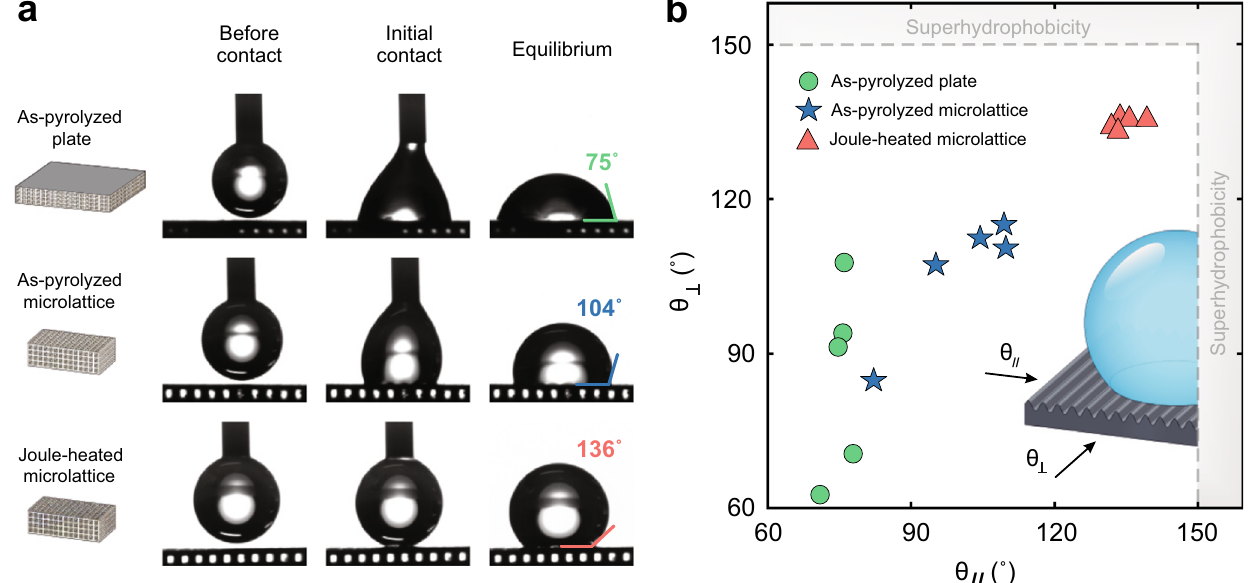
Fig. 4 Water contact angle measurements on pyrolytic and Joule-heated carbon. a Representative con fi gurations of a 0.7 µ l water droplet on an as- pyrolyzed plate, as-pyrolyzed microlattice, and Joule-heated microarchitecture. Digital images were taken before contact, at the initial contact, and at equilibrium. The water contact angles were measured along the direction parallel to the SLA-induced grooves and prove that the lattice topology transforms pyrolytic carbon into a hydrophobic material, with Joule heating further enhancing the contact angle. b Water contact angles measured at equilibrium parallelly ( θ // ) and perpendicularly ( θ ? ) to the groove direction, as shown in the inset. In Joule-heated microlattices, the water contact angle attains a tight distribution around 135°, approaching